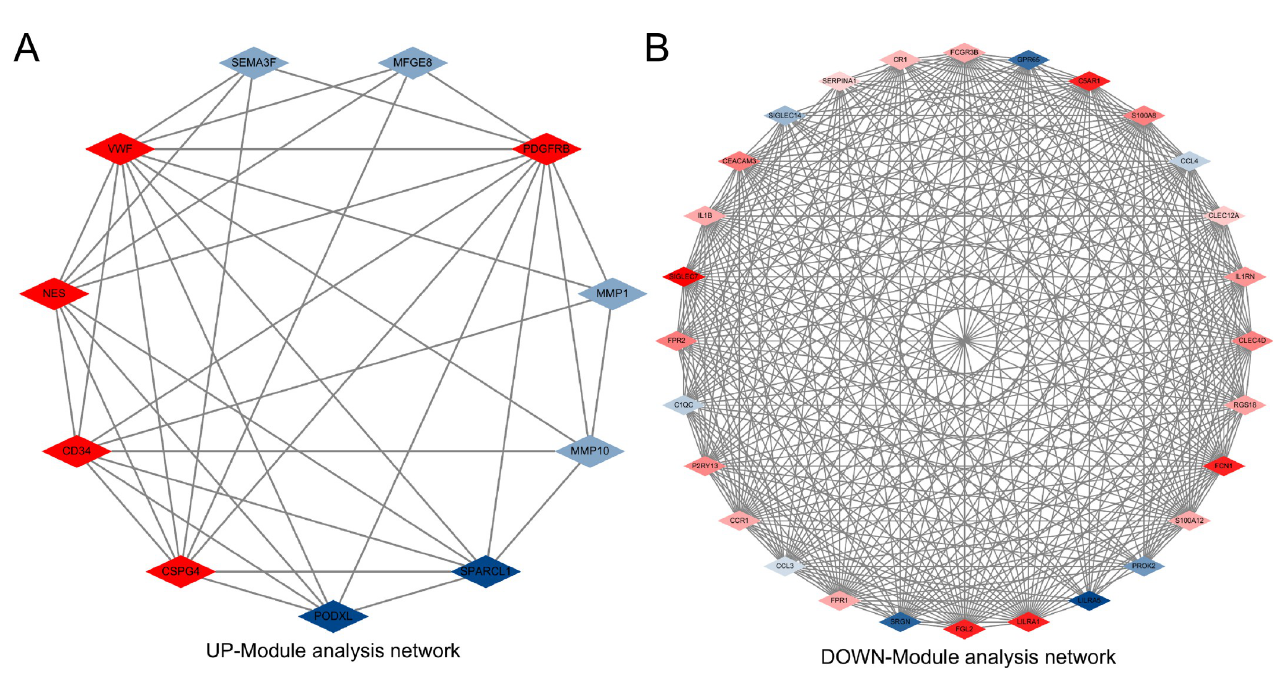
Fig 6. The module analysis network was obtained from the PPIs network in Fig 5. PDGFRB, VWF and SIGLEC7 are highlighted in red, as these 3 hub nodes are common between GSE147507 and TCGA-LIHC. This network represents the highly interconnected region of the PPIs network.